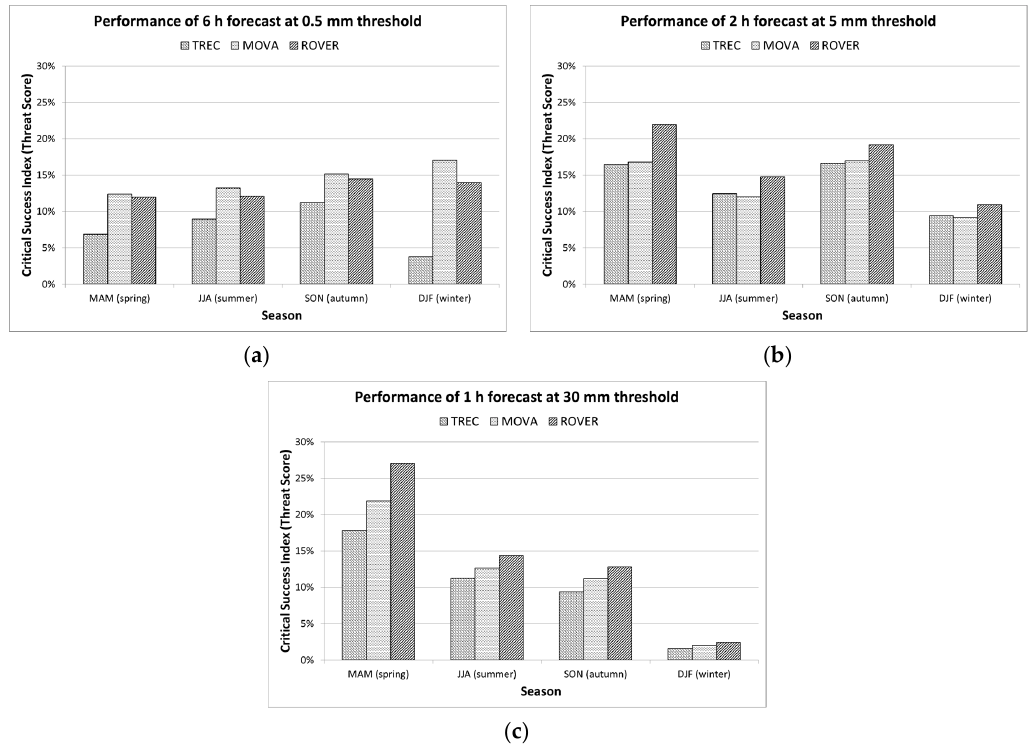
Figure 9. A seasonal comparison of the performance of various radar echo tracking algorithms at: ( a ) 0.5 mm·h − 1 threshold for 6 h forecast; ( b ) 5 mm·h − 1 threshold for 2 h forecast; and ( c ) 30 mm·h − 1 threshold for 1 h forecast.